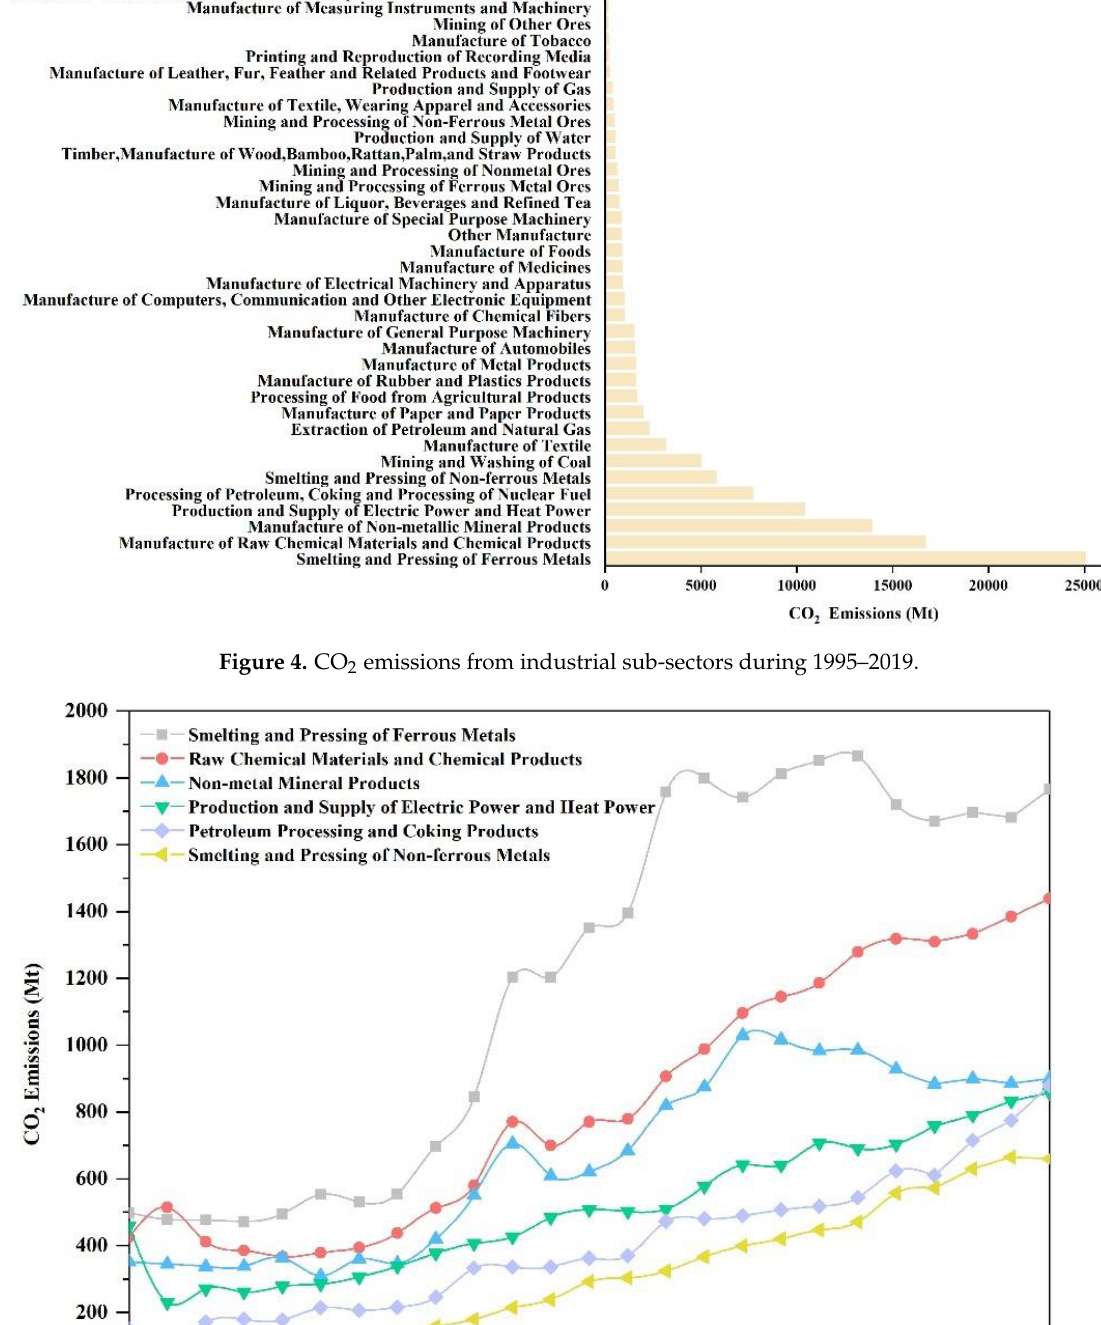
Figure 3. Proportion of CO 2 emissions in the excavation, manufacturing, electricity, gas and water production, and supply first-layer subsectors.